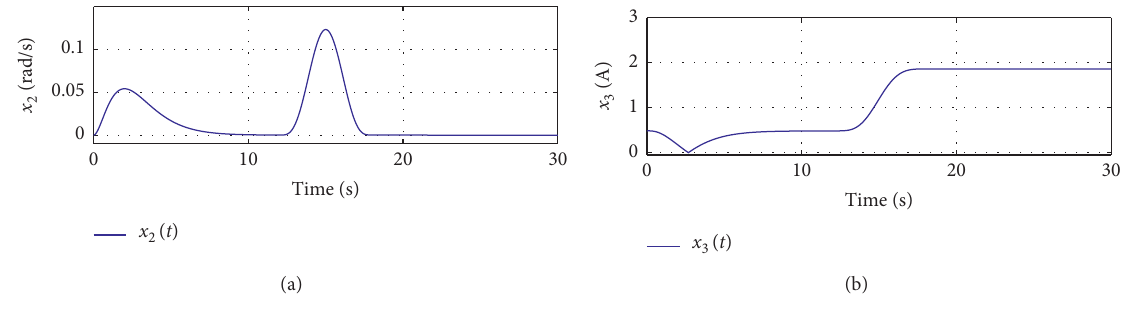
Figure 3: State behaviour in a rest-to-rest trajectory.